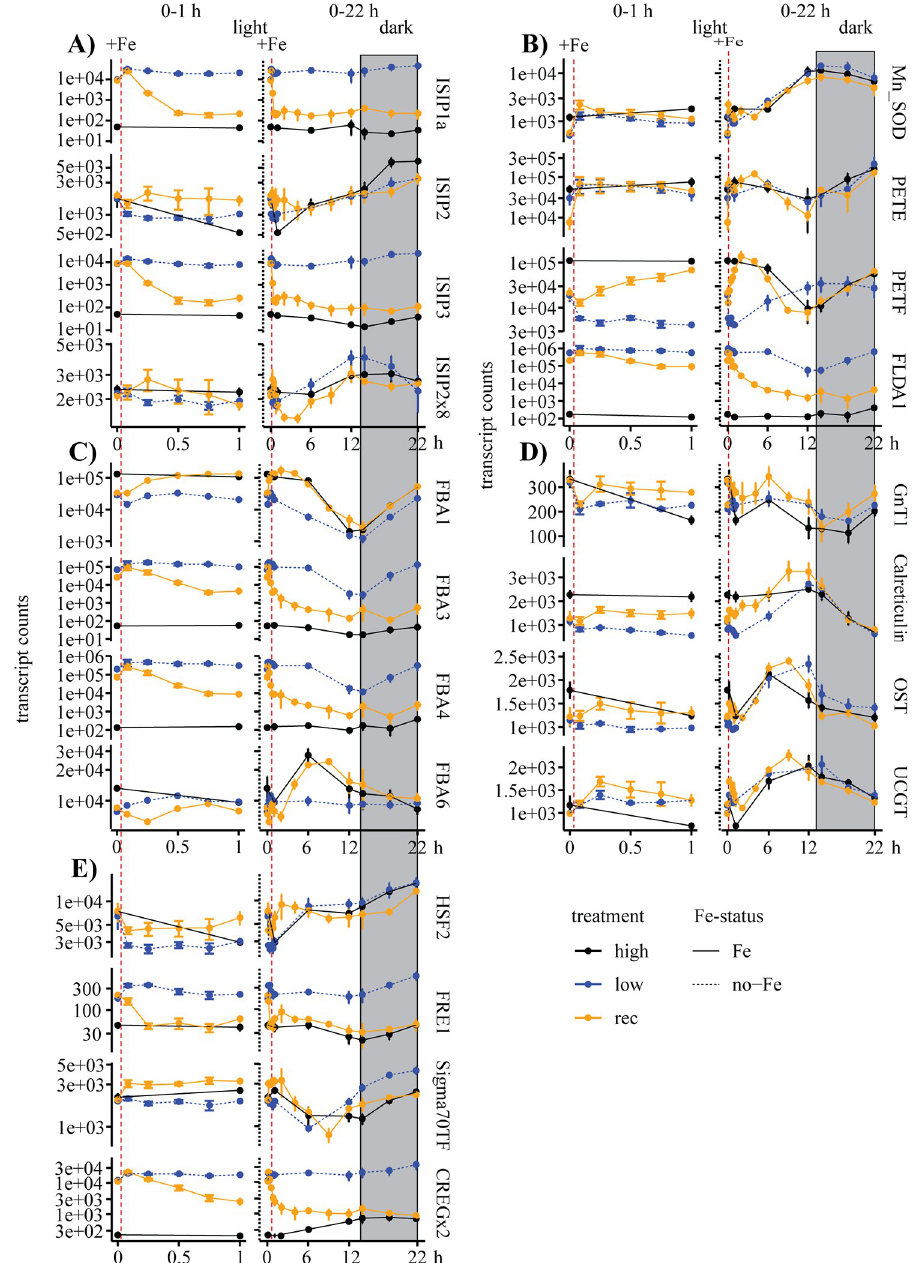
Fig 5. Time course of change in targeted transcript counts in high-iron, low-iron, and iron-recovery samples over the 6 h and the 22 h periods. Normalized transcript counts are on the y-axes vs time in hours on the x-axes, with 0 h representing 7 AM. Grey boxes indicate the dark phase. The response within the first hour is shown on the left, and the addition of iron is indicated with a red dashed line. Samples from the long-term experiment are shown on the right. High-iron, low-iron, and recovery samples are shown in black, blue, and orange, as in previous figures, with error bars indicating standard errors (S.E.). Transcripts are grouped: (A) iron starvation-induced proteins (ISIP), (B) proteins involved in photosynthesis, (C) Fructose-bisphosphate aldolases (FBA), (D) proteins involved in the glycosylation pathway, (E) transcription factors (HSF, Sigma70TF), iron reductase (FRE1) and a protein of unknown function